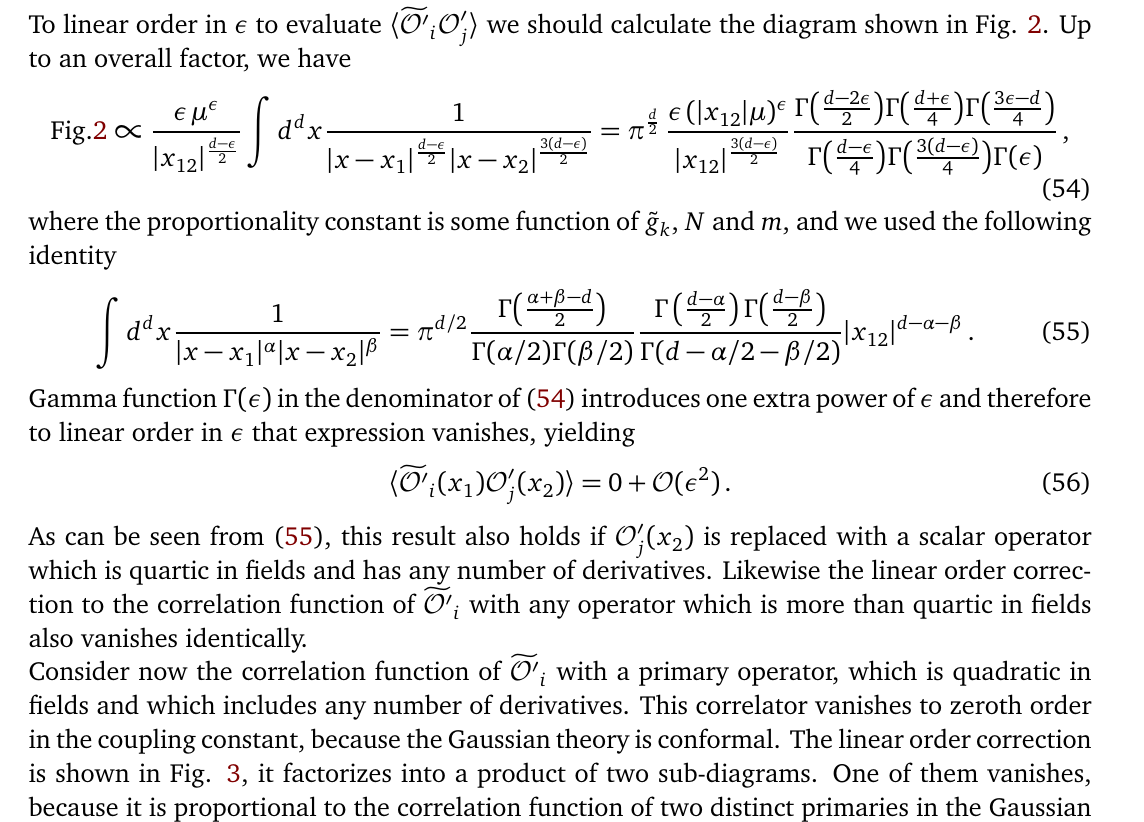
Figure 3: Linear order contribution to the correlation function of (cid:102) O (cid:48) built off two scalar fields and any number of derivatives (solid square). Solid lines represent propagators of the scalar fields. Integration is done over the insertion point x